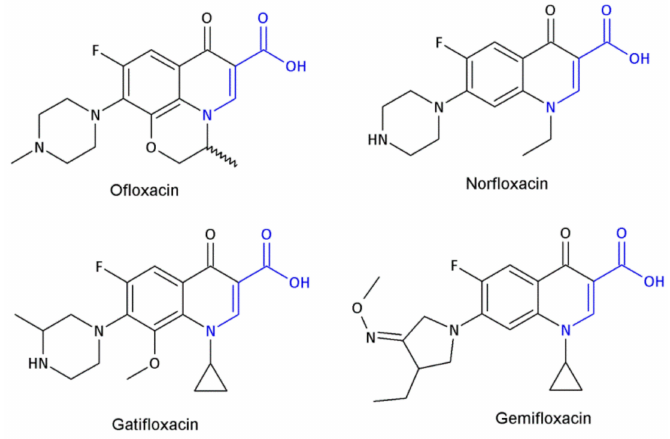
Figure 3. The structures of ofloxacin, norfloxacin, gatifloxacin and gemifloxacin, unsaturated β -amino acid heterocycles exhibiting antibacterial activities.